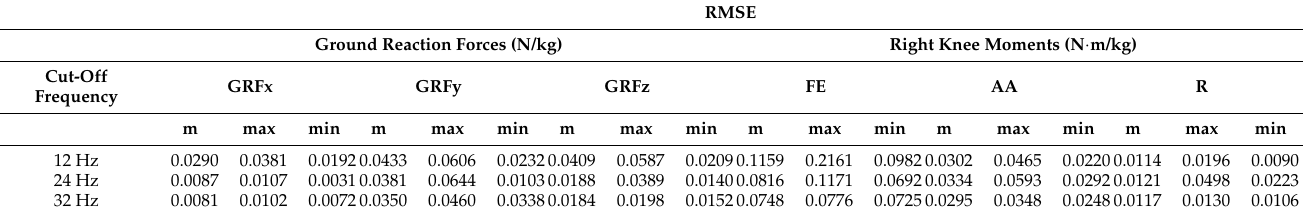
Table 4. Mean, maximum, and minimum RMSE values corresponding to each target variable predicted by the network according to cut-off frequency of the Butterworth Low-pass filter applied to IMU data. The predicted variables are the 3D GRFs, the Flexion/Extension (FE) moment, the Adduction/Abduction (AA) moment, and the Rotation (R) moment at the right knee joint.